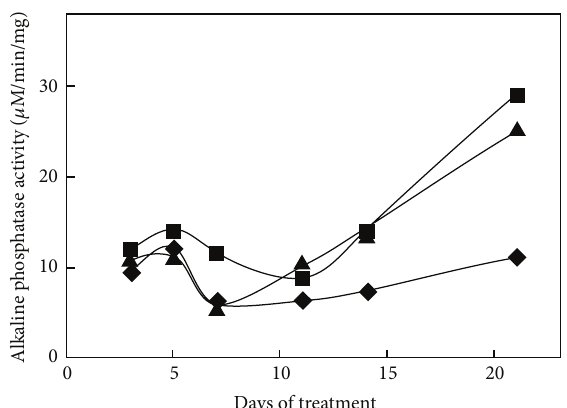
Figure 6: Effects of the Pf BMP-2 synthetic polypeptide and the synthetic polypeptide of the knuckle epitope of human BMP-2 on the endogenous expression of alkaline phosphatase in C3H10T1/2 cells. C3H10T1/2 cells were plated into 48-well dishes for 2 days and then treated with 80 𝜇 g/well Pf BMP-2 synthetic polypeptide or 80 𝜇 g/well synthetic polypeptide of the knuckle epitope of human BMP-2. Alkaline phosphatase activity was measured at endpoint, on the days indicated. ◼ - ◼ : the knuckle epitope of human BMP-2, 󳵳 - 󳵳 : Pf BMP-2 synthetic polypeptide, and ⧫ - ⧫ : in the absence of protein.